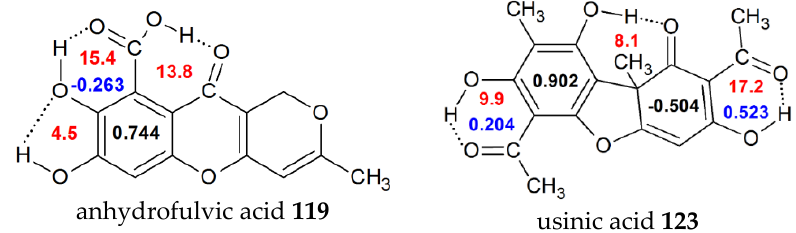
Figure 5. The energies, harmonic oscillator model of aromaticity HOMA and quasiHOMA indices for stable conformers of anhydrofulvic acid 119 (top) and usinic acid 123 (bottom). Values of quasiHOMA (in blue) and E HB (in red) were given in the centre of the hydrogen bonded ring, whereas the HOMA value was given in the ipso -ring.